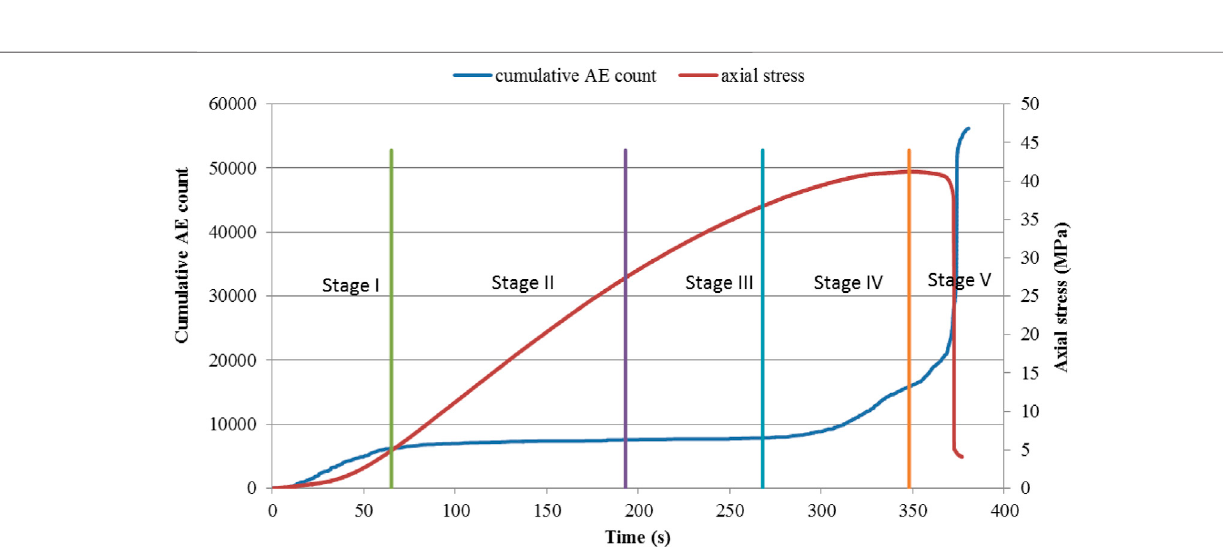
FIGURE 9 | Cumulative AE counts and axial stress versus loading time of uniaxial compression